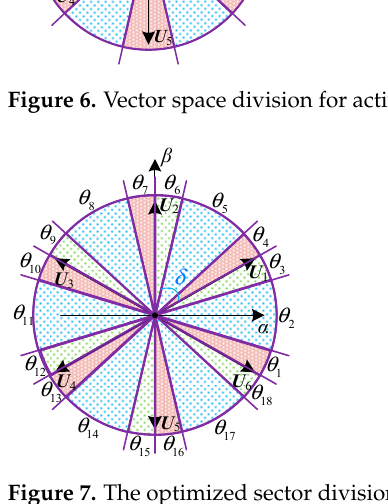
Figure 6. Vector space division for active power.